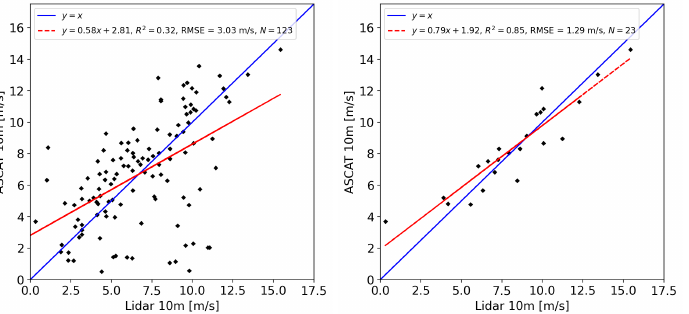
Figure 5. Scatter of extrapolated 10 m ferry lidar wind speed measurements with ASCAT 10 m. ( left ) All co-located extrapolated values ( right ) are filtered for near neutral stability ( − 0.2 ≤ ζ ≤ 0.2). The blue line is y = x and the red line is the resultant linear